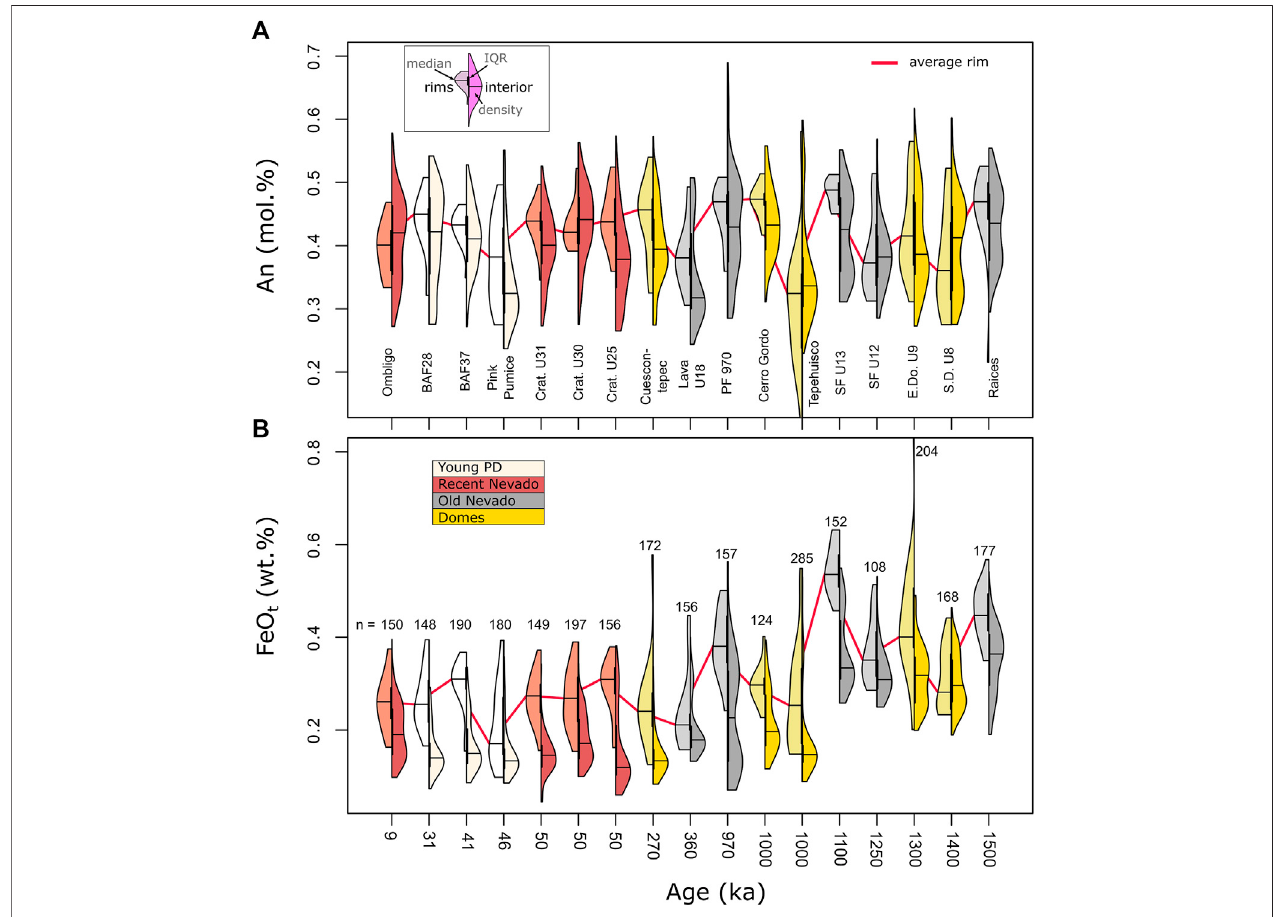
FIGURE 11 | Time variation of plagioclase compositions shown as two-sided “ violin ” plots. The left half (light colored) of each “ violin ” shows the density distributionofplagioclaserims,whiletherighthalf(fullcolors)showsthedensitydistributionofcrystalcores.Themedianineachofthesedistributionsisindicatedby a horizontal black line and the interquartile range is marked by vertical bold black lines at the base of each distribution. Color coding re fl ects the eruptive groups: Young PD (beige), Recent Nevado (red), Old Nevado (gray), Domes (gold). (A) Time variation of An content (mol%) for different eruptions (labels). (B) Time variation of FeO t content (wt%). The number of analysis ( n ) for each of the eruptions is shown on top of the diagrams in B ).